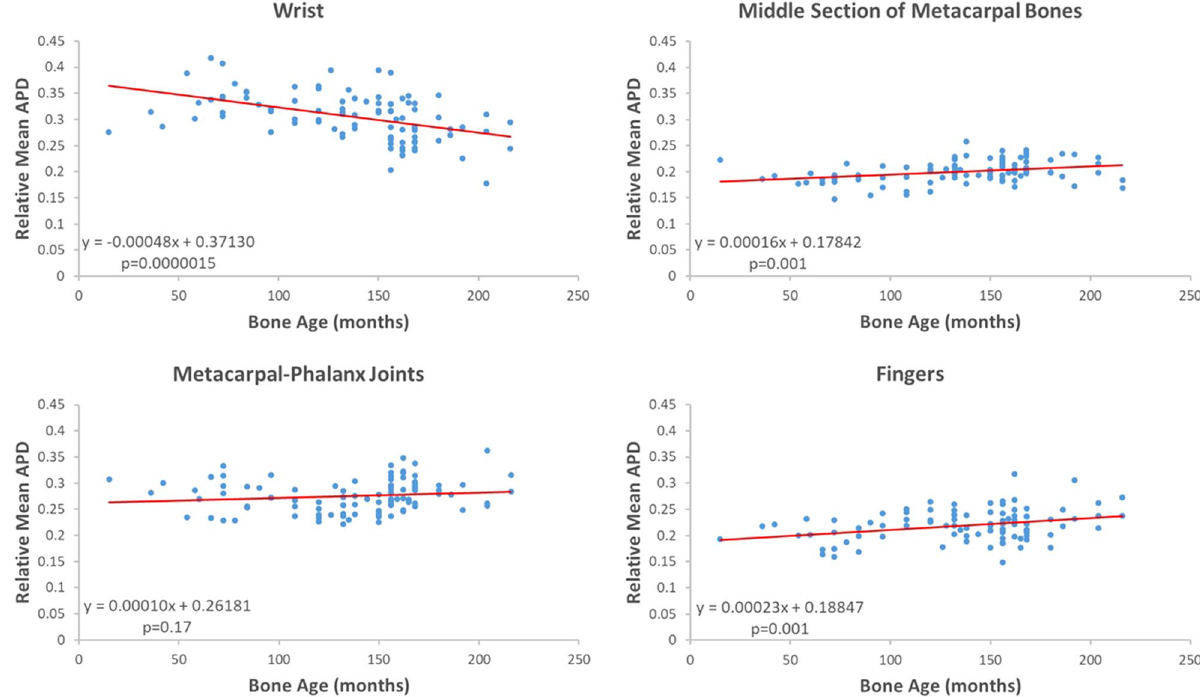
Figure 3. Relative mean APDs were plotted versus the reference bone age for bone-containing ROIs of test data. In each panel, the red line represents the regression equation shown in the figure. The p-value indicates the statistical significance level of the nonzero slope of the regression